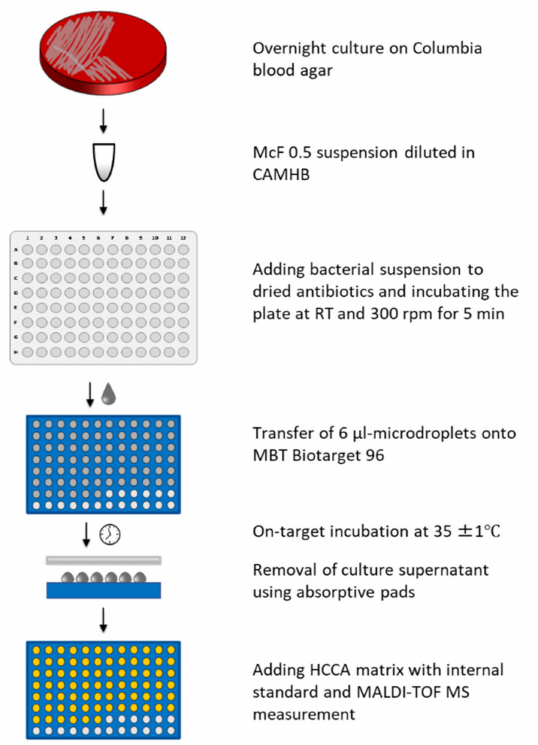
Figure 1. Workflow of the MALDI-TOF MS direct-on-target microdroplet growth assay (DOT-MGA). Mass spectra were interpreted using the MBT FAST prototype software (Bruker Dal- tonics GmbH & Co. KG, Bremen, Germany). In case of bacterial growth in a microdroplet with antibiotic, bacterial biomass is successfully detected by MALDI-TOF MS after the incubation period, and the result is interpreted as bacterial resistance against the tested concentration of an antimicrobial. In contrast, failed detection of bacterial biomass by MALDI-TOF MS defines inhibition of bacterial growth by an antibiotic in the tested con- centration. The categorization of isolates as S, I or R was performed based on results for one or two breakpoint concentrations included for each antibiotic. The test was defined as valid, if the bacterial growth in control without an antibiotic was successfully detected by the MBT FAST prototype software. The rates of categorical agreement (CA), very major error (VME, the number of false S results with DOT-MGA divided by the number of R results with standard method), major error (ME, the number of false R results with DOT-MGA divided by the number of S results with standard method) and minor error (mE, the number of false categorizations involving I category) were calculated for each antibiotic and each time point separately, as recommended by ISO [20] and FDA